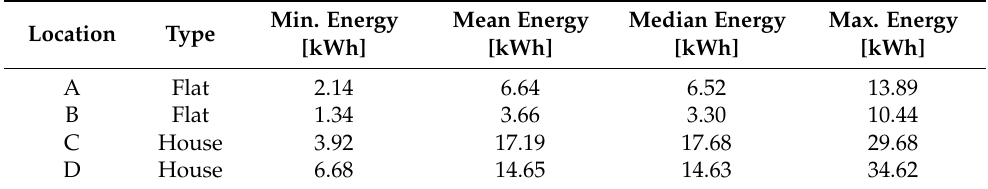
Table 1. Summary of location characteristics. The type of location, minimum, mean, median and maximum values of observed daily energy consumption are presented for each location. Location